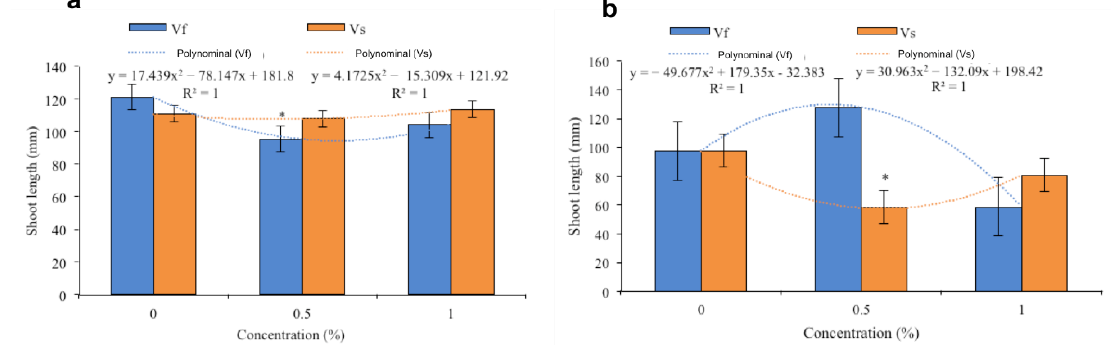
Figure 3. Effects of the aqueous extracts of Verbesina sphaerocephala and Verbesina fastigiata at different concentrations on leaf length in ( a ) Solanum lycopersicum and ( b ) Cucumis sativus . Columns denoted by an asterisk (*) are statistically different from the control. The values represent the average ( n = 20 seedlings); the bars represent the standard error.